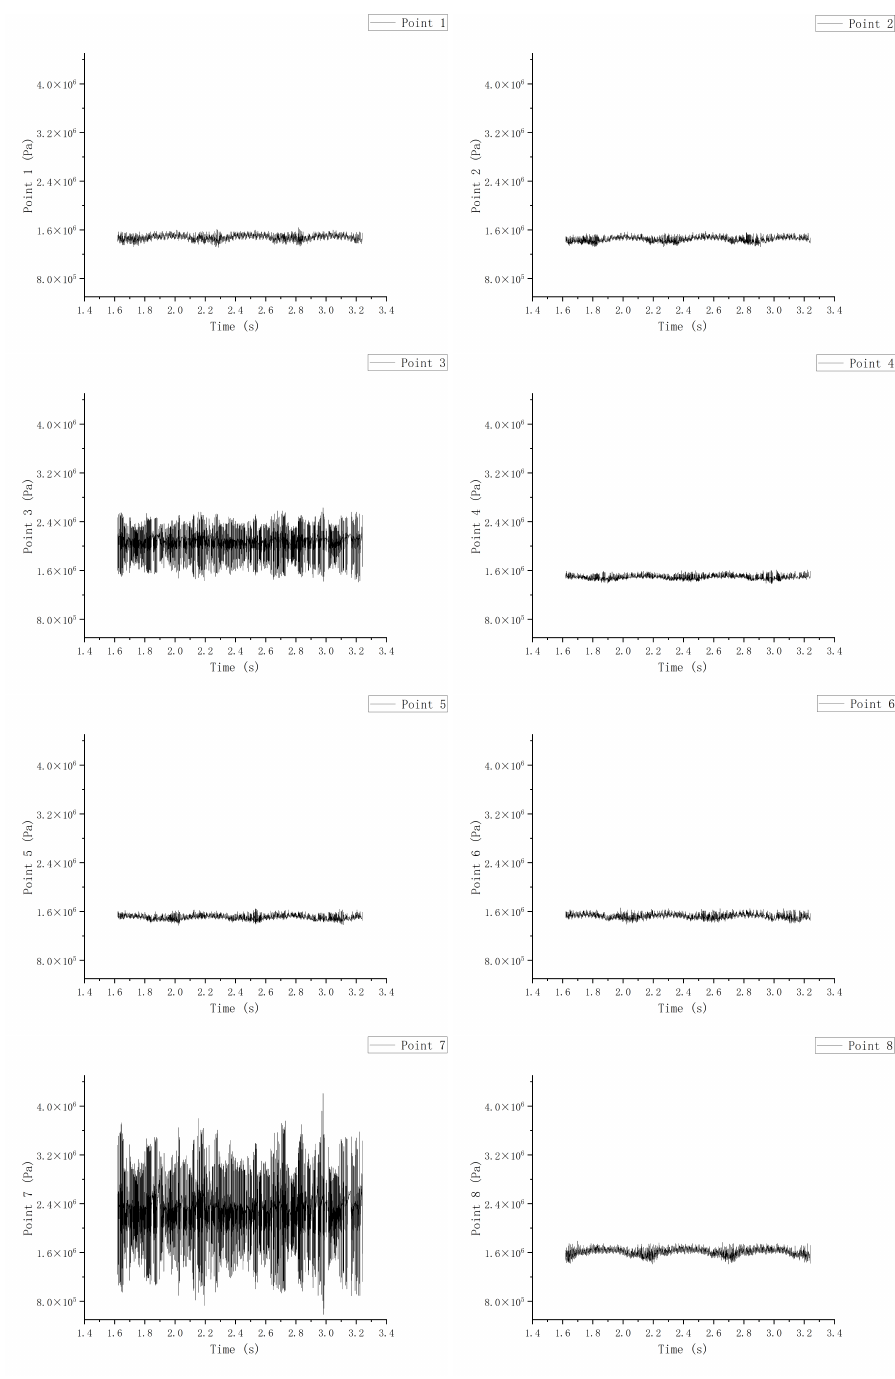
Figure 19. The pressure distributions of the lower crown